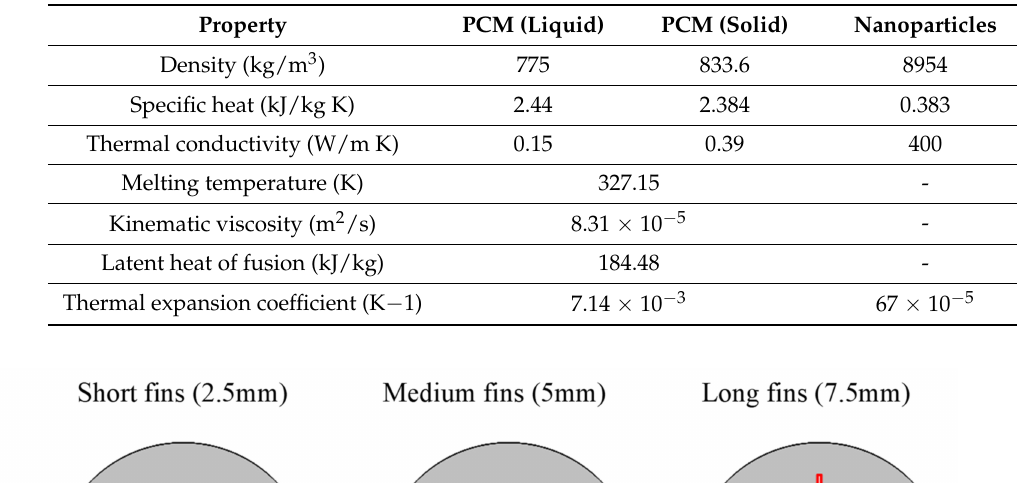
Table 1. Thermophysical properties of the PCM and nanoparticles [45,46].